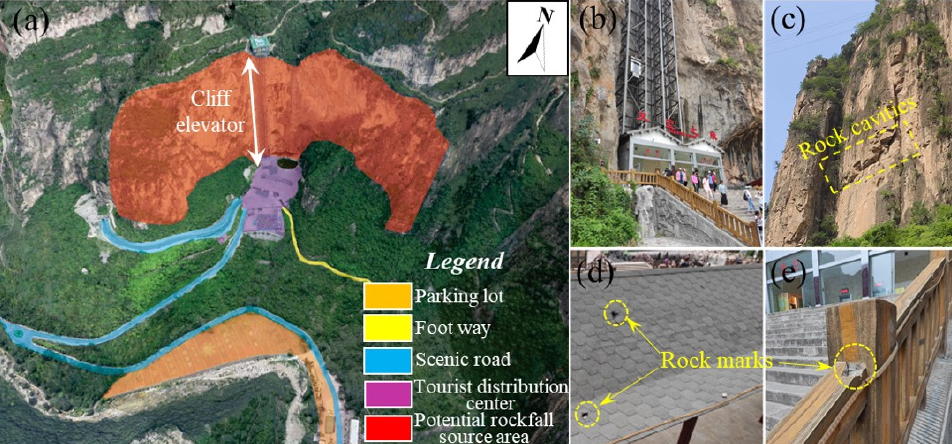
Figure 19. Potential rockfall point of the Sky City scenic spot. ( a ) Panoramic view of the Sky City scenic spot. ( b ) Outdoor sightseeing elevator built on the cliff wall. ( c ) Rock cavity on the cliff wall. ( d , e ) Damage to facilities caused by rockfalls.